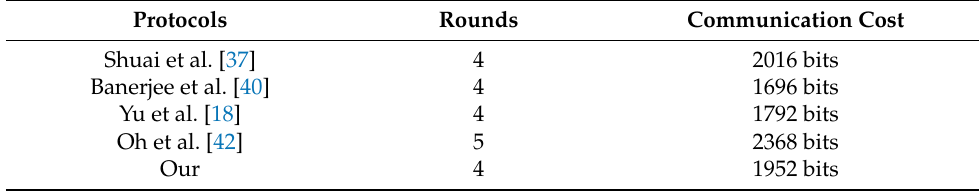
Table 6. Communication cost